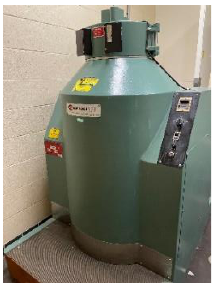
Figure 6. Gammacell 220 Co-60 Irradiator.